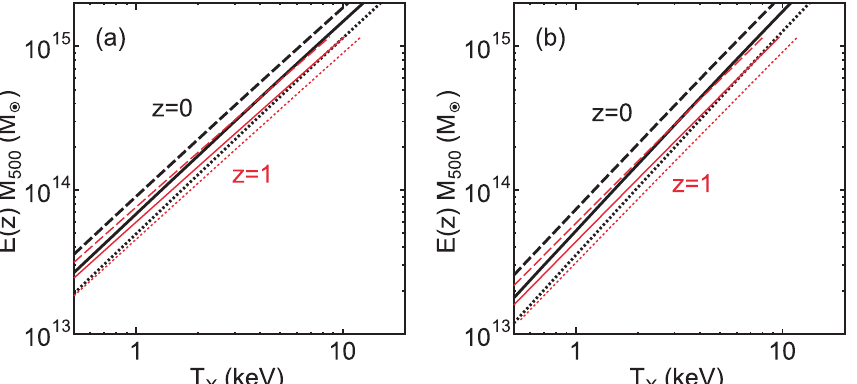
Figure 6. M ∆ – T X relation for ∆ = 500 derived from the fundamental plane and the c ∆ – M ∆ relation (solid lines): ( a ) n = − 2; and ( b ) n = − 2.5. The thick black lines and the thin red lines represent z = 0 and 1, respectively. Dotted and dashed-lines correspond to the dispersion of the c ∆ – M ∆ relation ( ± 0.1 dex) shown by numerical simulations (Figures are reconstructed from Figure 1 of [47]).